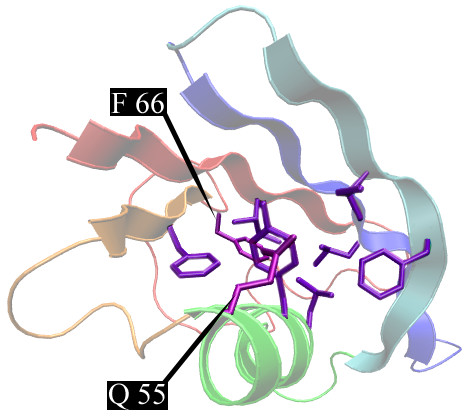
Ribbon diagram of the human SUMO-1 protein structure [21]. The displayed region corresponds to the segment shown in the alignment in Figure 1. The core residues L24, I34, F36, F64, F66, I88 located in the beta-strands and L44, L47, K48, Y51, Q55 in the helix form critical contacts in the helix-sheet interface of the SUMO core. These residues are shown in the stick mode (in purple). The highlighted Q55 and F66 residues align with residues mutated in the rad60-1 (K263E) [15] and rad60-3 (F272V) [20] variants (see also Figure 1).